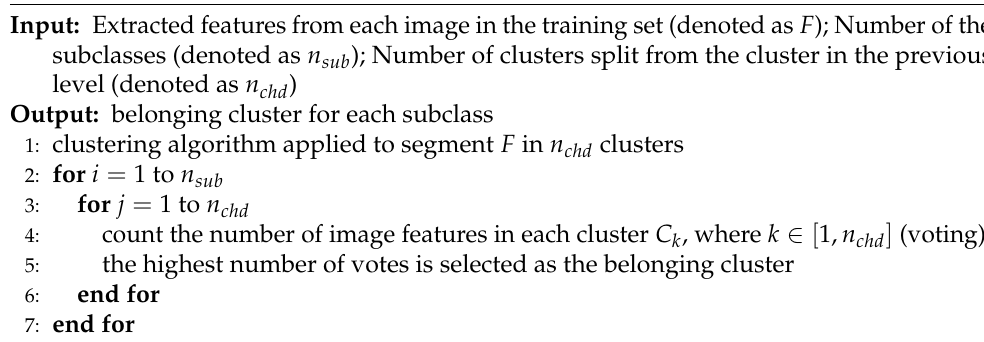
Algorithm 1 Determining the belonging classes for the subclasses.